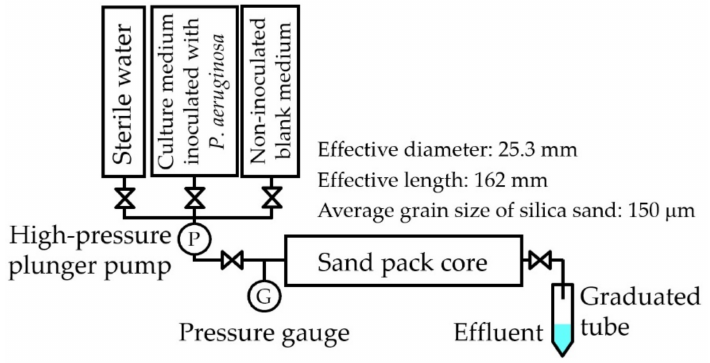
Figure 2. A schematic image of the setup used for the flooding